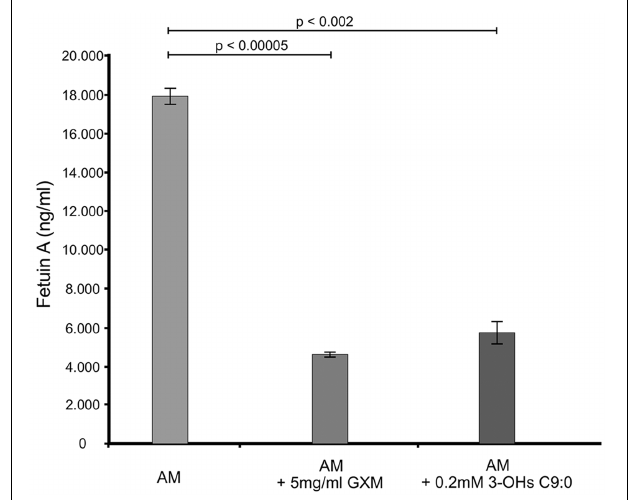
FIGURE 1 | The ELISA quantitative results showing the levels of fetuin A present across the different experimental conditions i.e., GXM-treated amoeba (AM) and 3-OH C9:0-treated amoeba, including the control i.e., non-treated amoeba cells. The results indicate that 3-hydroxy C9:0, similar to GXM, may possess an anti-phagocytic quality. GXM, glucuronoxylomannan; 3-OH C9:0, 3-hydroxy